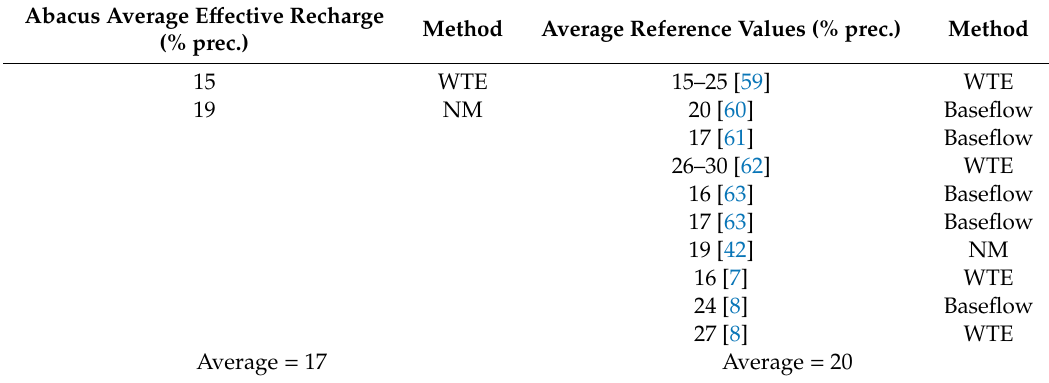
Table 2. Regionalized average e ff ective recharge rates and average literature reference values obtained for similar environmental conditions (Cerrado